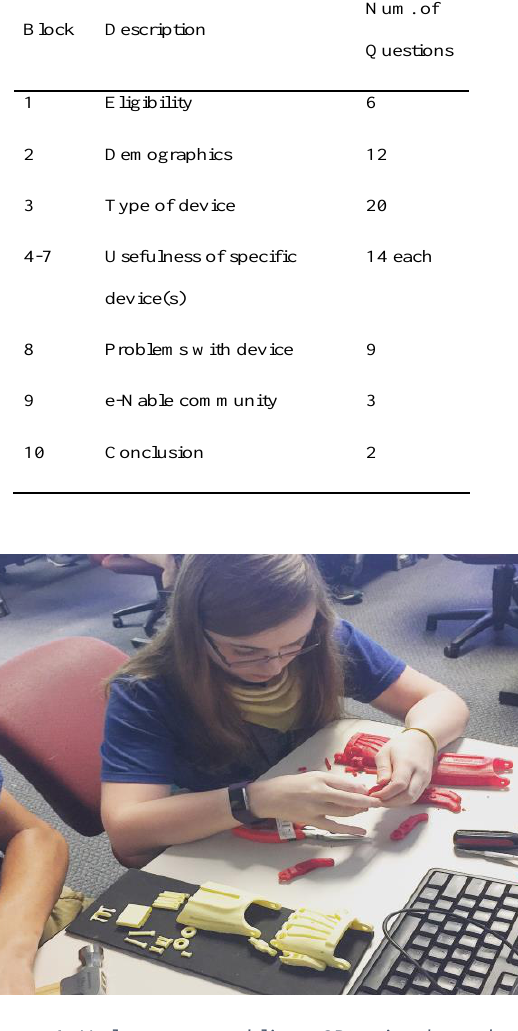
Table 1: Overview of survey contents Figure 1: Volunteer assembling a 3D- printed prosthetic device